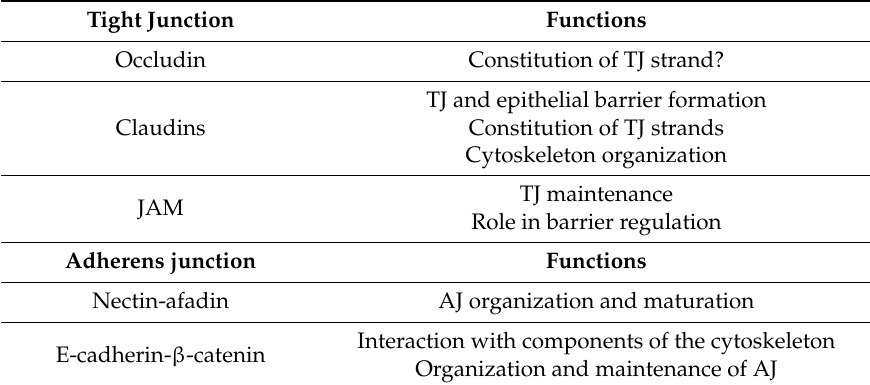
Table 1. Components and functions of the apical junctional